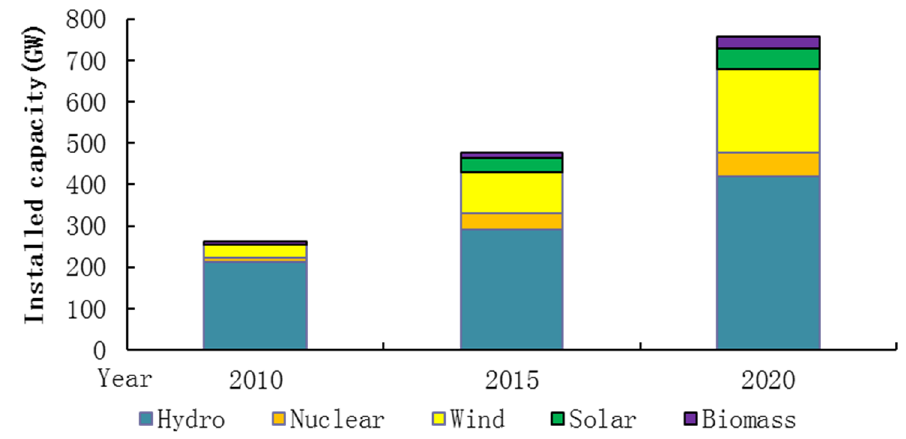
Figure 2. Published situation and targets for installed capacity of renewable energy towards 2015 and 2020 in